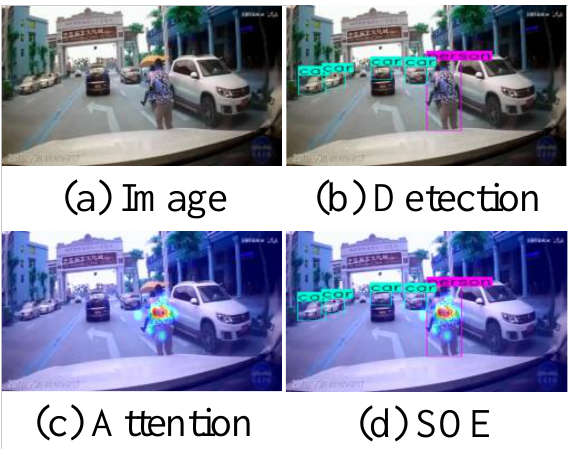
Figure 1. Drivers pay attention to the most important objects in the scene: ( a ) current driving scene, ( b ) results of object detection, ( c ) driver attention map after visualization, and ( d ) fusion map that projects the driver attention map onto the results of the object